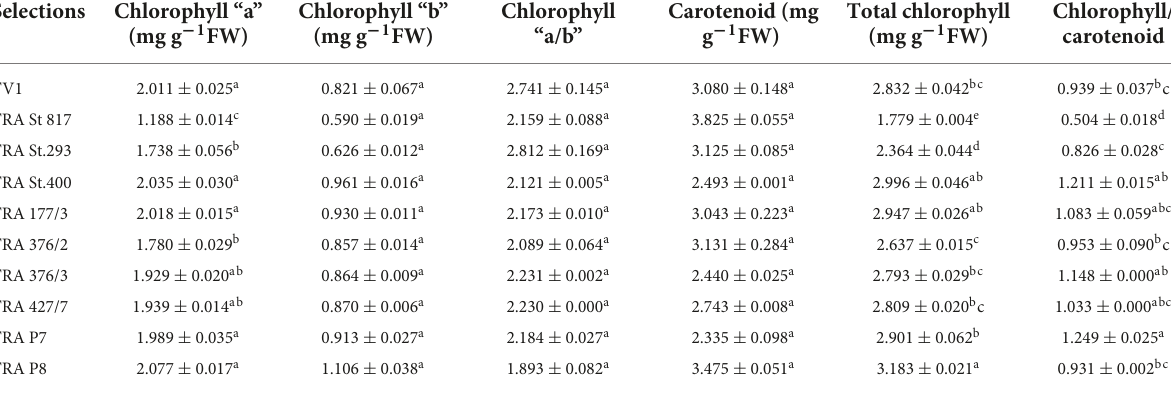
TABLE 3 Chlorophyll a, chlorophyll b, chlorophyll a/b ratio, total chlorophyll, carotenoids and chlorophyll/carotenoids ratio in the selected tea germplasm.